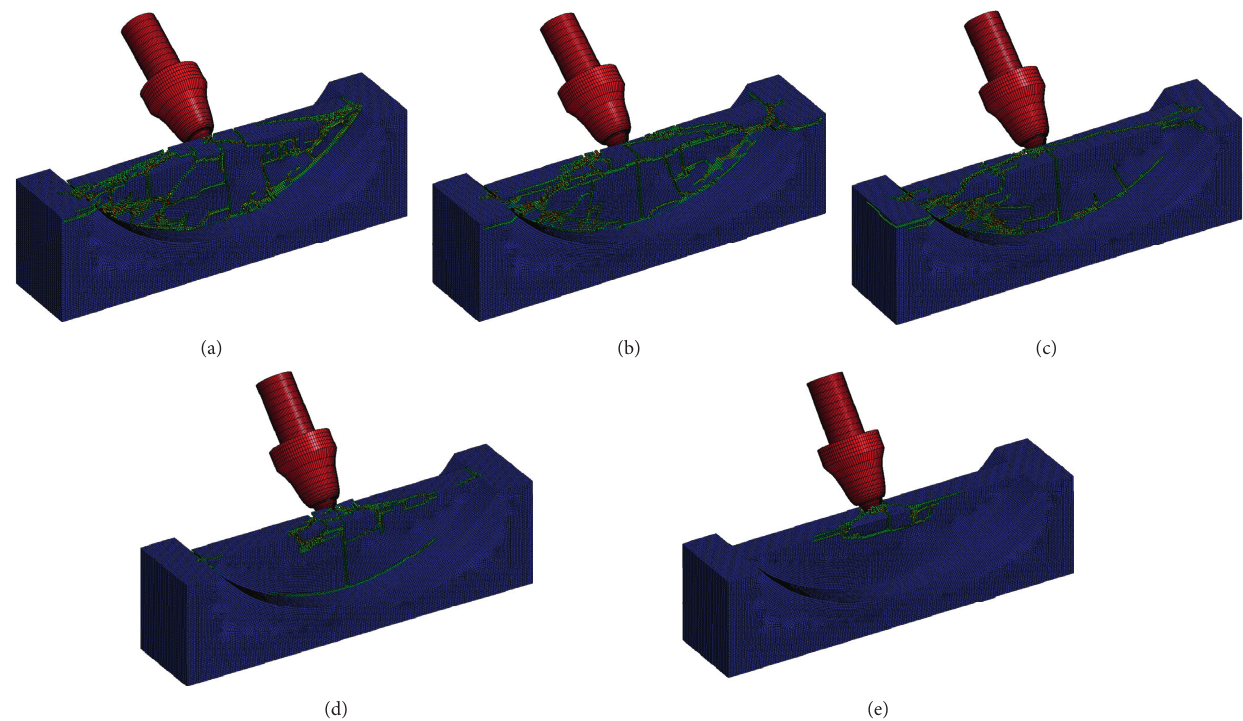
Figure 10: The numerical simulation of conical pick with various cutting angles cutting arc rock